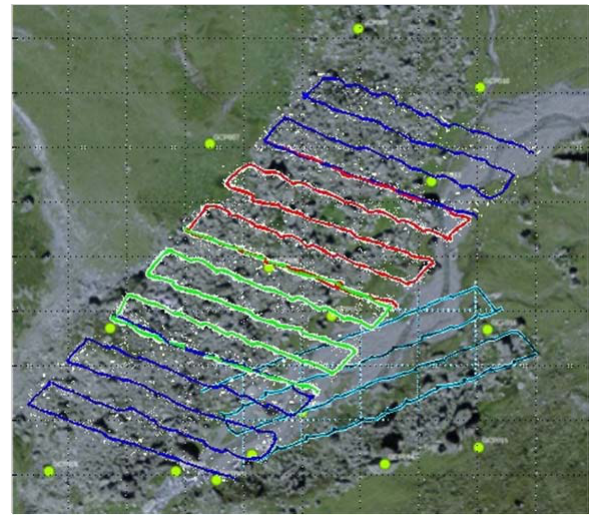
Figure 7: Flight Path of the UAV